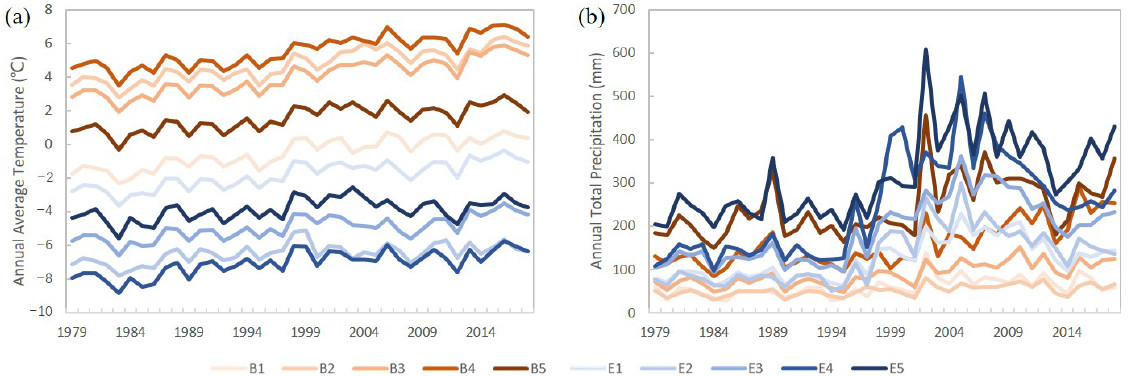
Figure 5. Annual average temperature ( a ) and annual total precipitation ( b ) of the fine-grained climate types B1–B5 and E1–E5 during 1979 to 2018.